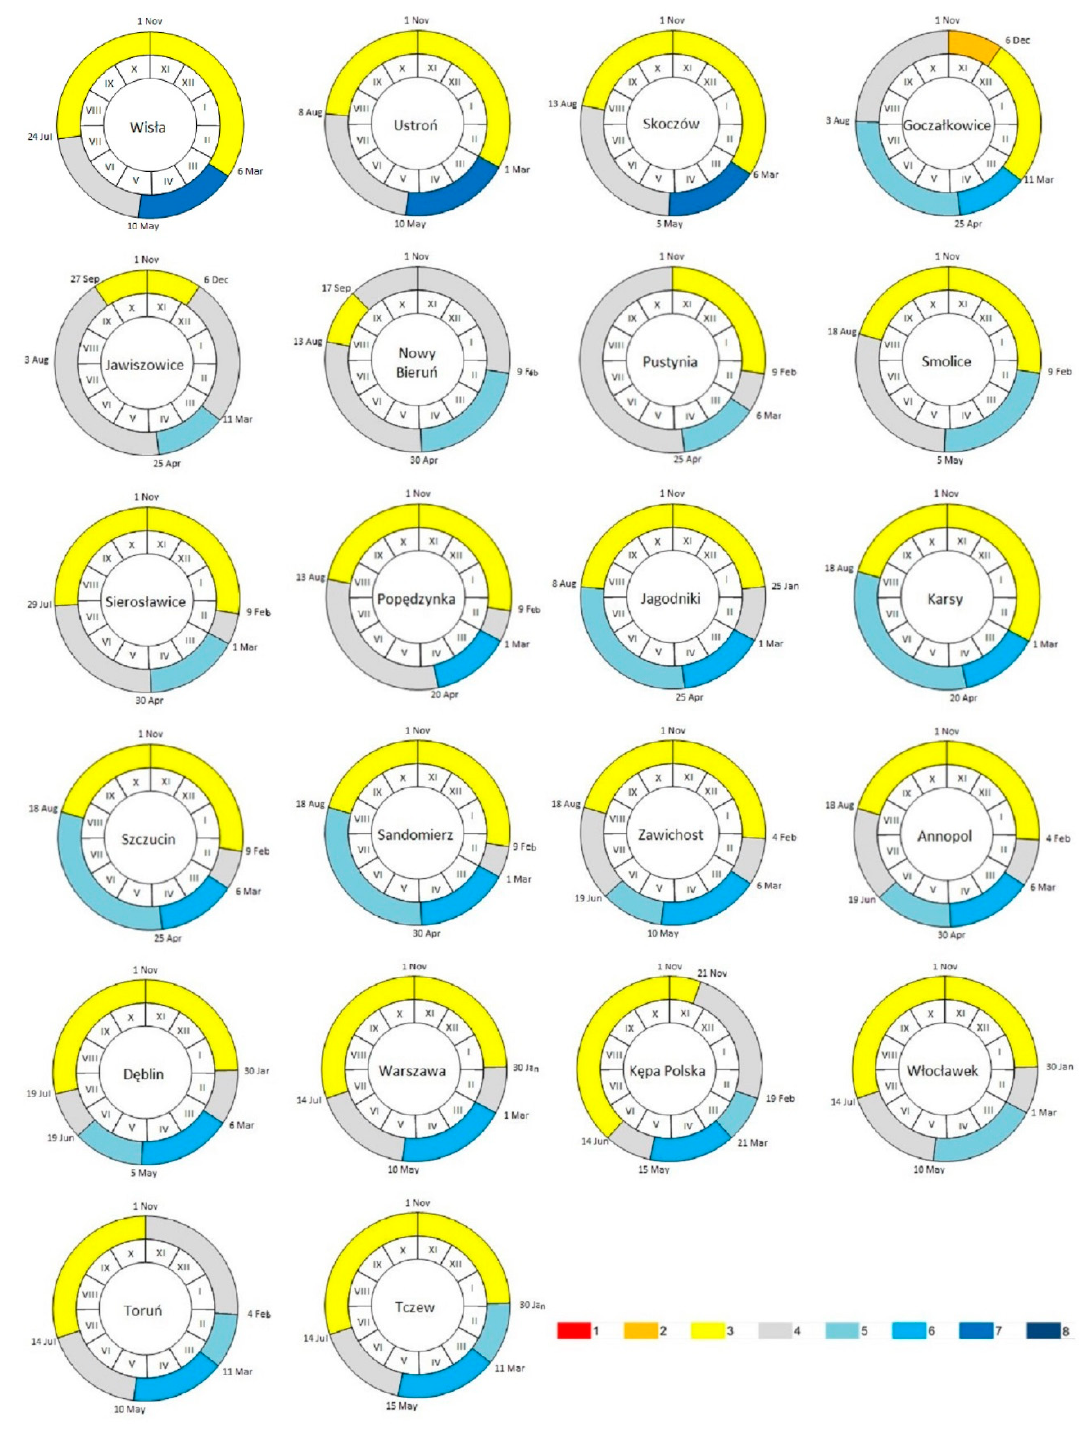
Figure 7. Sequence of hydrological periods in average annual cycle in 22 gauges along the Vistula River mainstream. Types of hydrological periods: 1—deep low-water, 2—average low-water, 3—shallow low-water, 4—normal period, 5—low high-water, 6—average high-water, 7—high high-water, 8—very high high-water.